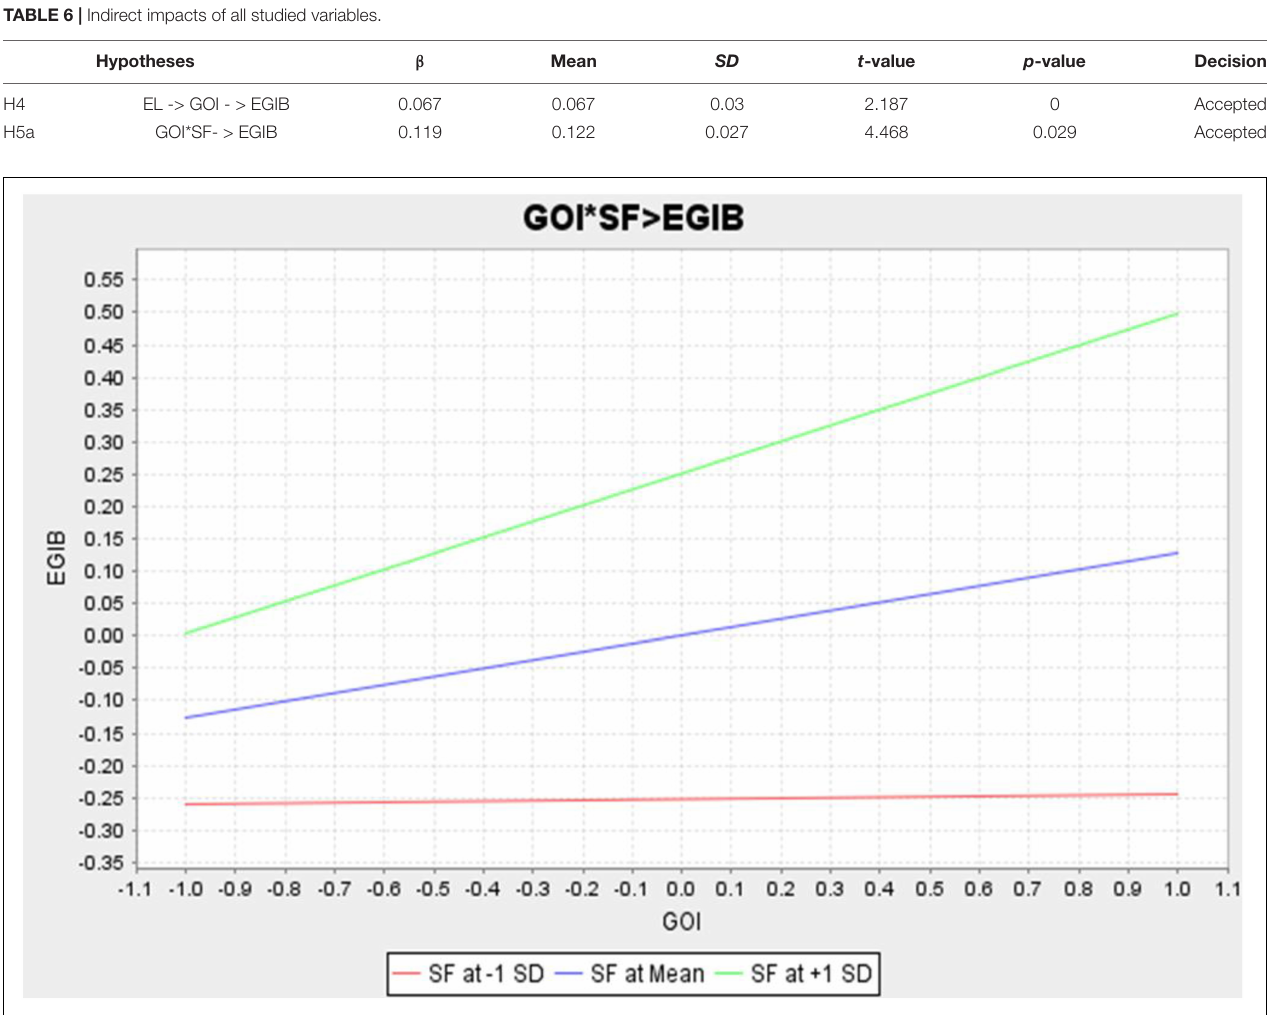
FIGURE 3 | Moderating effect of SF between GOI and